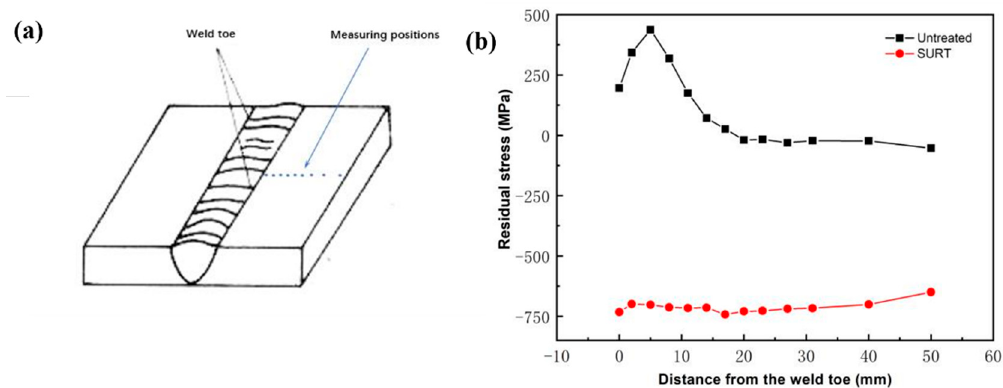
Figure 7. ( a ) Schematic diagram of measure residual stress. ( b ) Variation of residual stress of T4003 ferritic stainless steel welded joint before and after SURT.